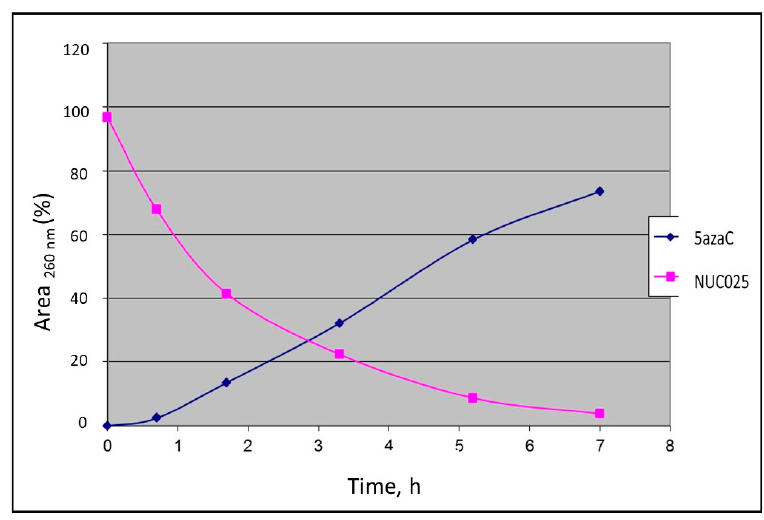
Figure 2. Hydrolysis of NUC025 in saline with release of 5-azaC at 20 °C measured by spectrophotometry. To confirm these results, the GI 50 of NUC013 was compared to that of NUC041 in two cancer cell lines: human non-small cell lung cancer (NSCLC) NCI-H460 and colon cancer HCT-116 (Table 1). Table 1. Comparison of GI 50 between NUC013 and its prodrug, NUC041. Compound